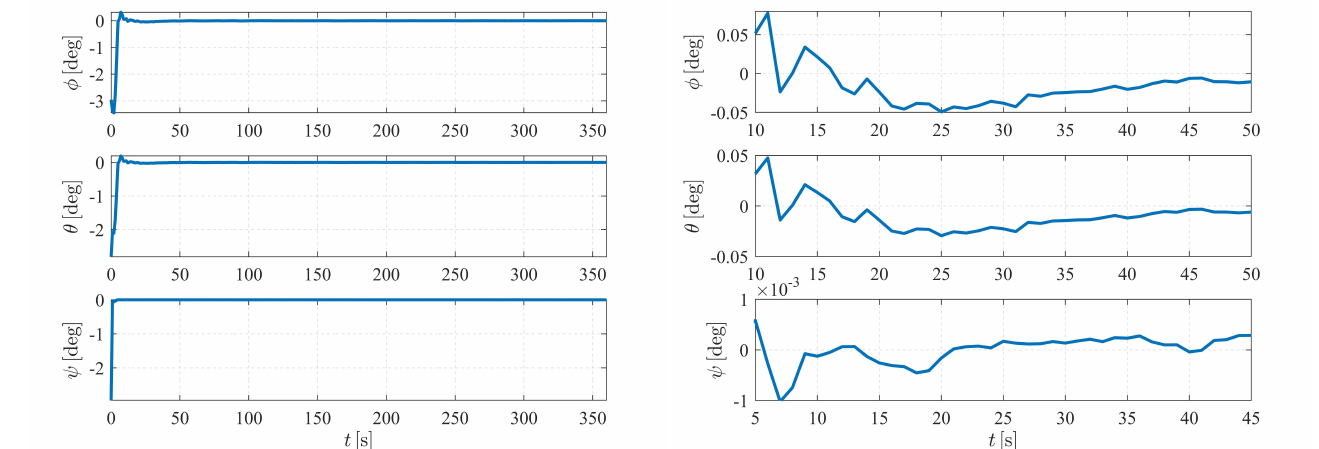
Figure 4. Attitude determination errors of case I (nonperturbation) and the corresponding larger